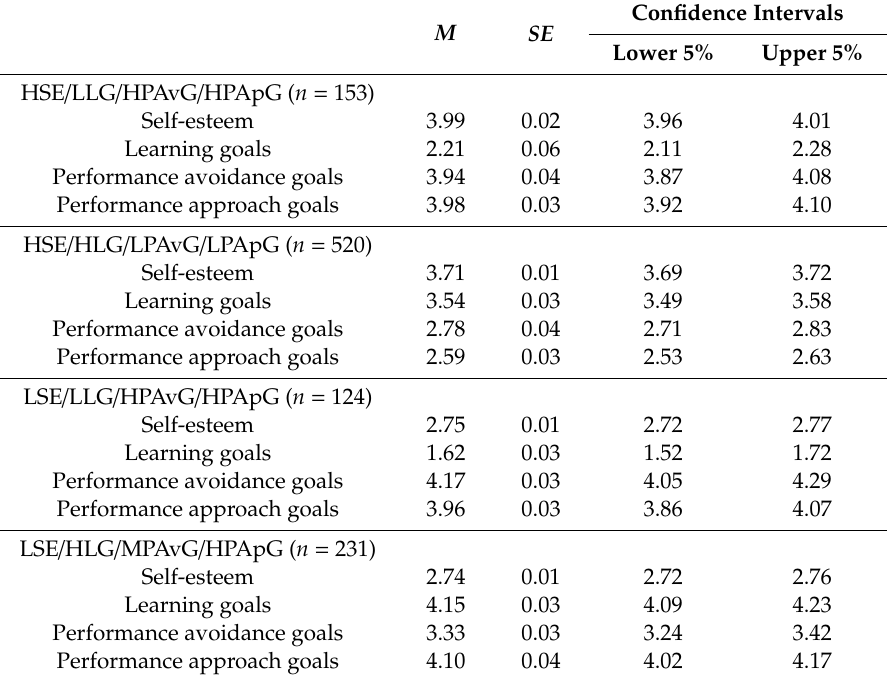
Table 4. Description of latent profiles (means, standard errors, and confidence intervals).